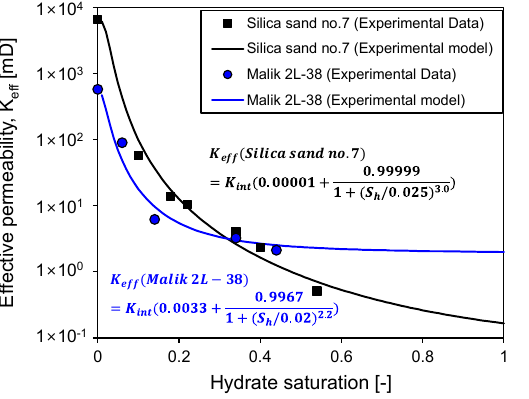
Figure 6. Application of proposed experimental model to the other experimental test data.